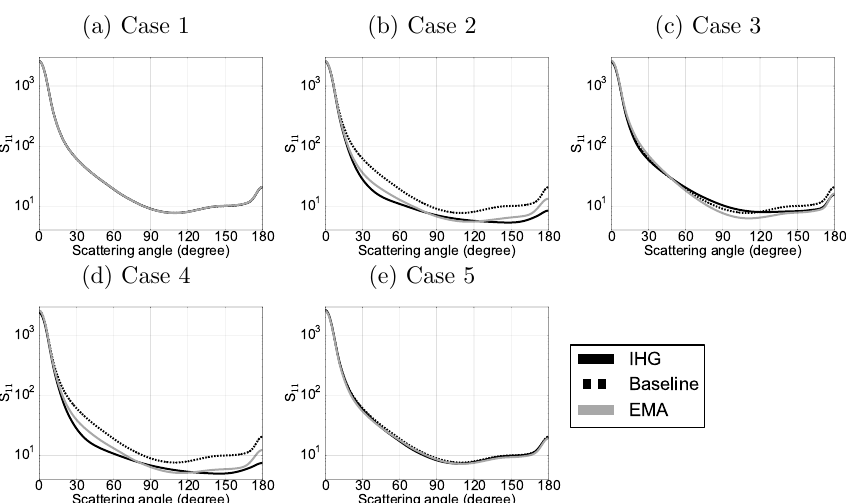
Figure 4. S 11 values for the inhomogeneous (IHG), the baseline, and the homogeneous (EMA) versions of all five of the internal structure cases as a function of the scattering angle.